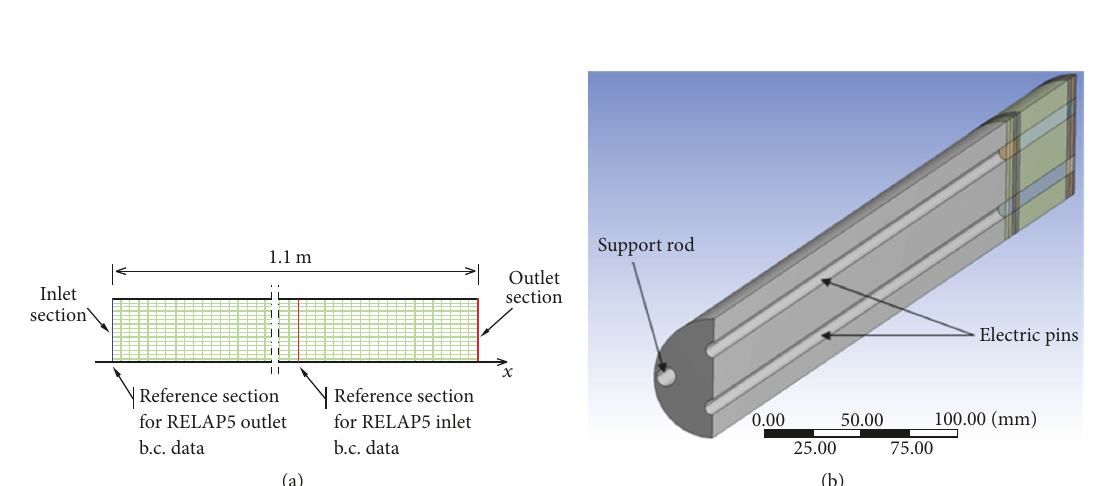
Figure 6: 2 D (a) and 3D (b) CFD domains of the Fuel Pin Simulator